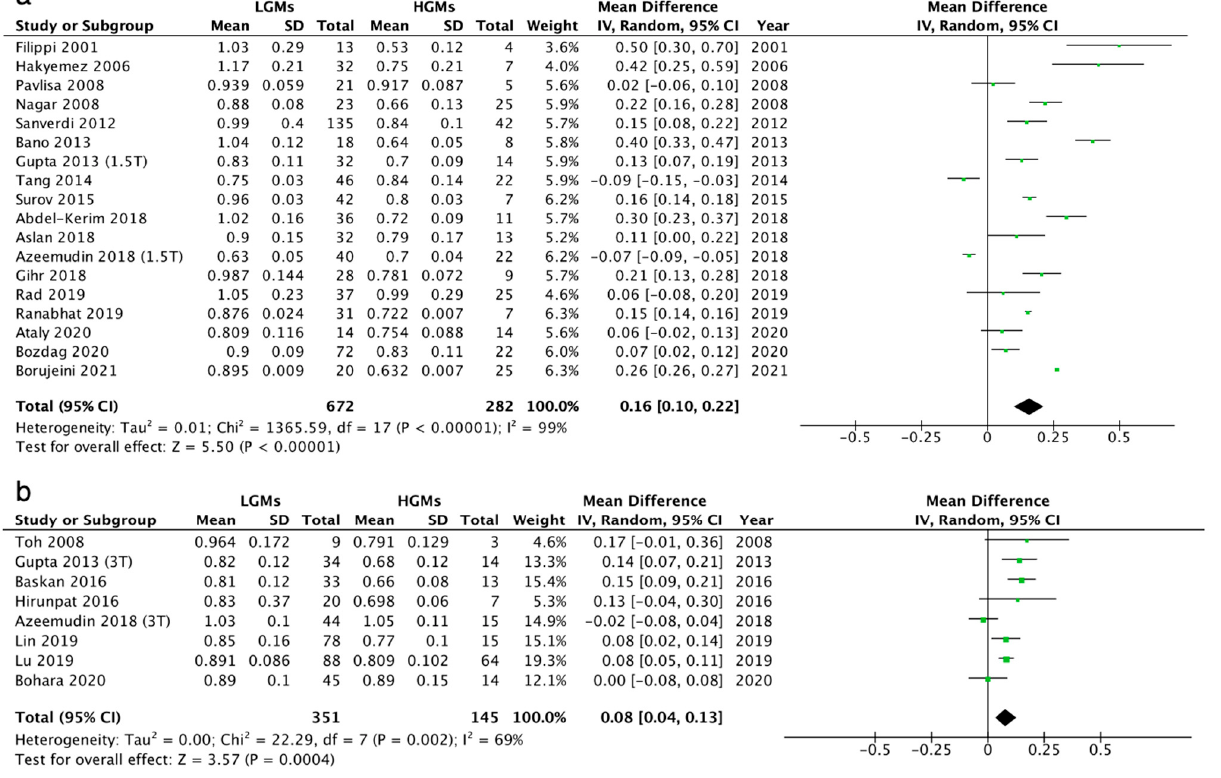
36 PPV: positive predictive value. NPV: negative predictive value.